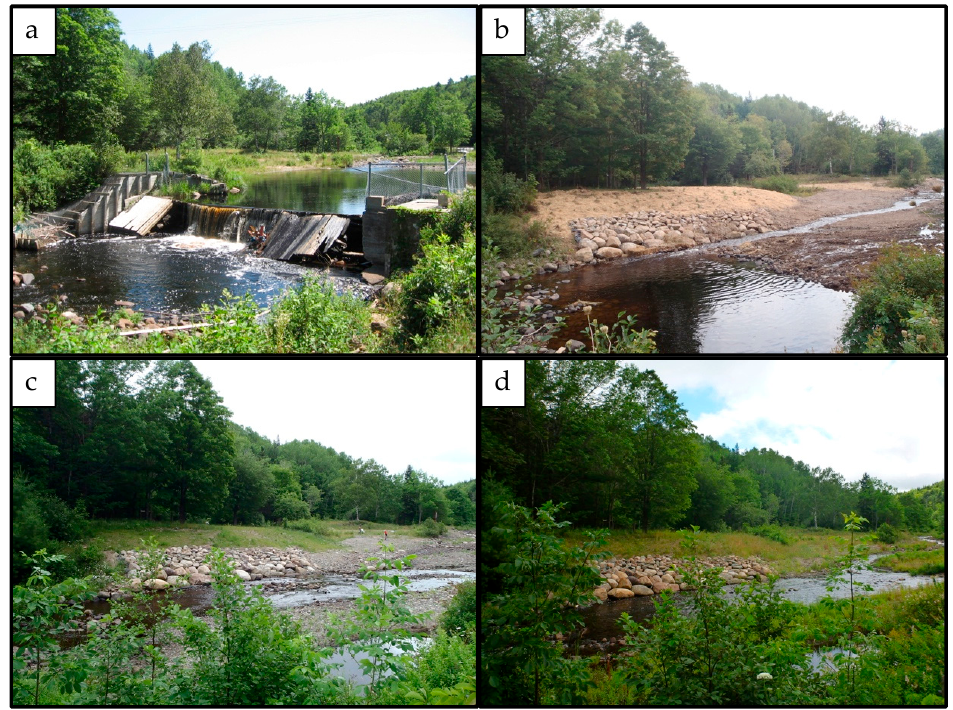
Figure 2. Dam removal project photo documentation. ( a ) pre-removal 6 August 2009; ( b ) post-removal 14 September 2011; ( c ) post-removal 6 July 2012; ( d ) post-removal 29 July 2013.